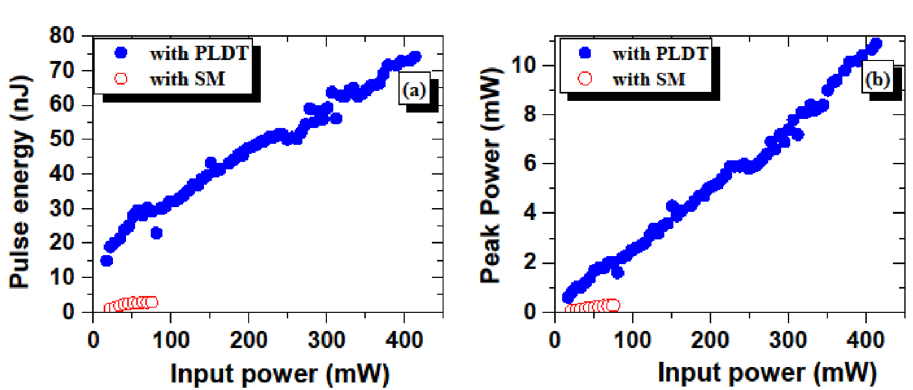
Figure 12. Measured ( a ) pulse energy and ( b ) peak power as a function of pump power for SA prepared using SM (hollow red circles) and PLDT (solid blue